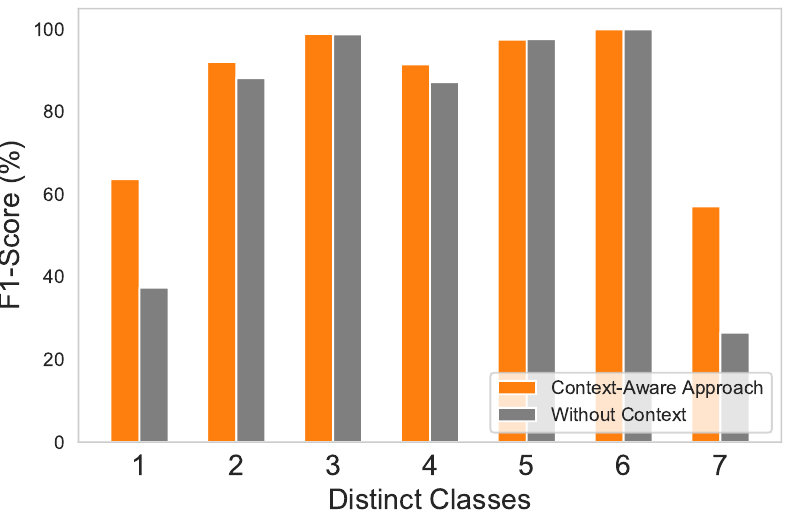
Figure 8. ET average F1-score comparison for distinctive classes using context-aware approach vs. without-context